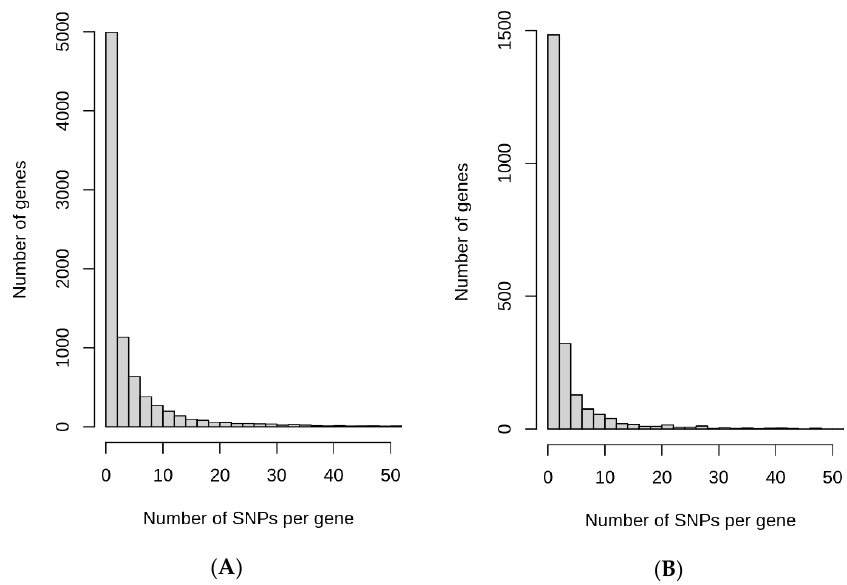
Figure 5. Distribution of the number of ARSA ( A ) and RACA ( B ) SNPs per gene. Table 4. Functional annotation of genes for ARSA SNPs obtained by the DAVID bioinformatics resource.